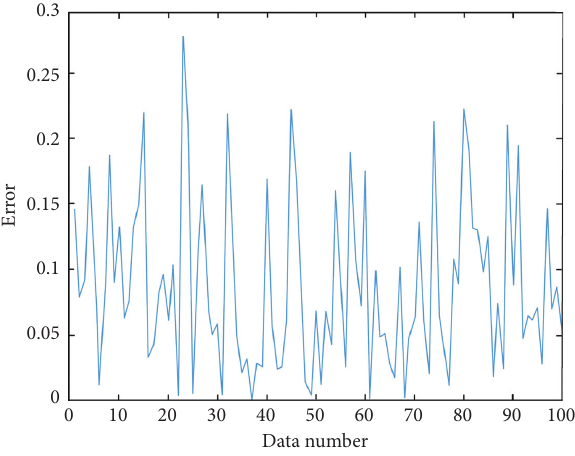
Figure 9: Predicted error Table 1: List of fault samples.